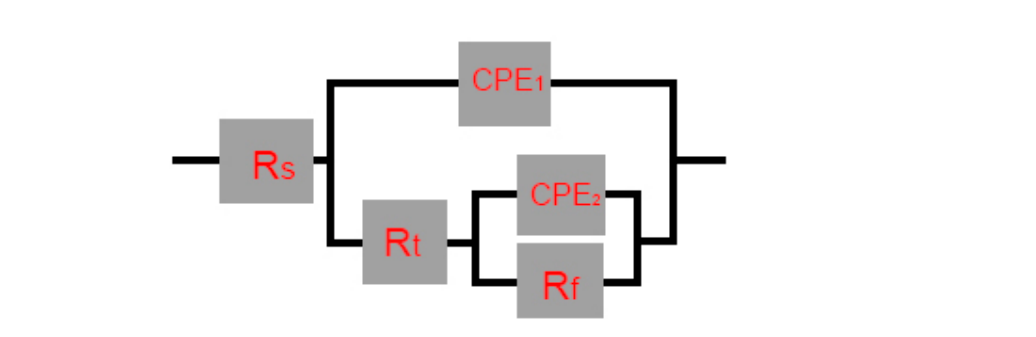
Figure 9. Electrochemical impedance equivalent circuit diagram of surfacing layer in 3.5% NaCl solution. Table 6. Fitting results of equivalent circuit of surfacing layer in 3.5% NaCl solution.